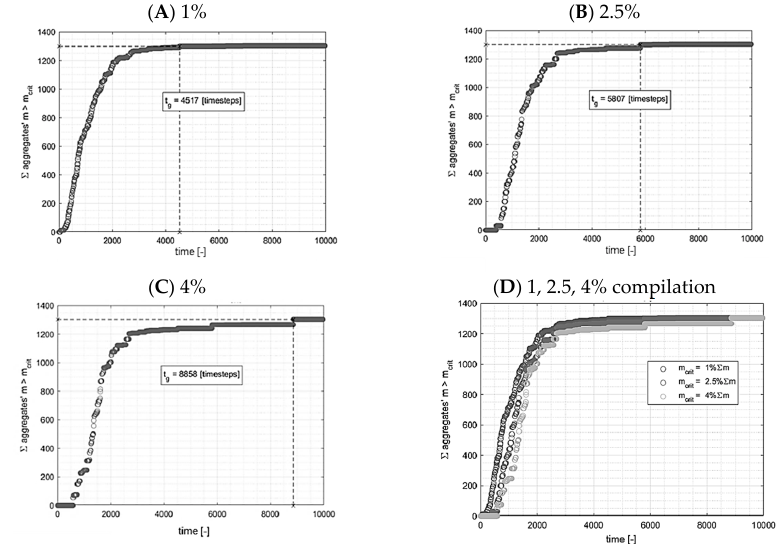
Figure 20. Impact of an aggregate threshold size on condensation kinetics curve.